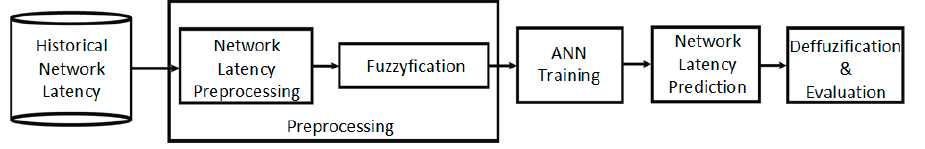
Figure 7. Summary of the neurofuzzy approach.